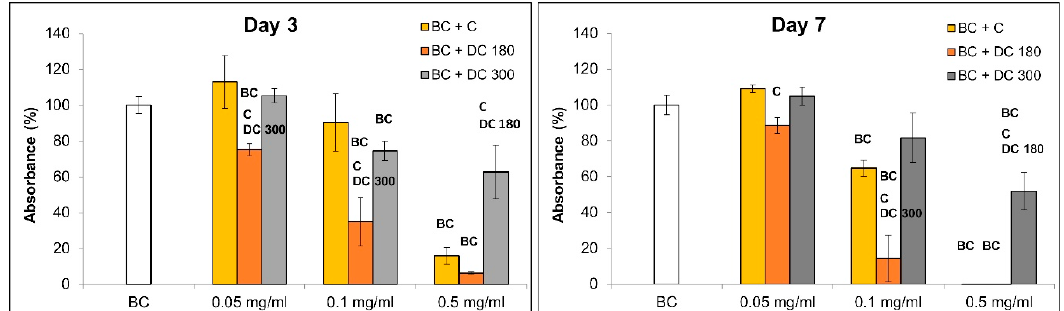
Figure 7. Mitochondrial activity of human dermal fibroblasts on pristine bacterial nanocellulose (BC) and on nanocellulose loaded with unmodified curcumin (BC + C), or with curcumin degraded at 180 °C (BC + DC 180) or at 300 °C (BC + DC 300 at various concentrations (0.05, 0.1 and 0.5 mg/mL) on days 3 and 7 after cell seeding. Arithmetic mean ± SD from 4 measurements, ANOVA, Student–Newman–Keuls method. Statistical significance ( p ≤ 0.05; depicted above the columns): BC compared with cells cultivated on BC; C , DC 180, and DC 300 compared with cells cultivated on BC + C, BC + DC 180, and BC + DC 300 with agents loaded at the same concentration.